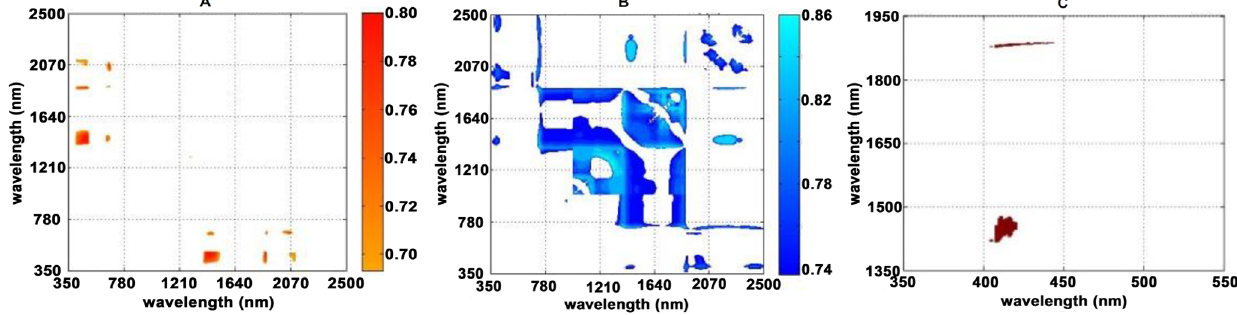
Figure 8. The 1:1 relationship between the predicted and observed LEWT based on NDSIb (R 1445 , R 487 ) for wheat before anthesis (A); the 1:1 relationship between the predicted and observed LEWT based on NDSIa (R 1714 , R 1395 ) for wheat after anthesis (B).